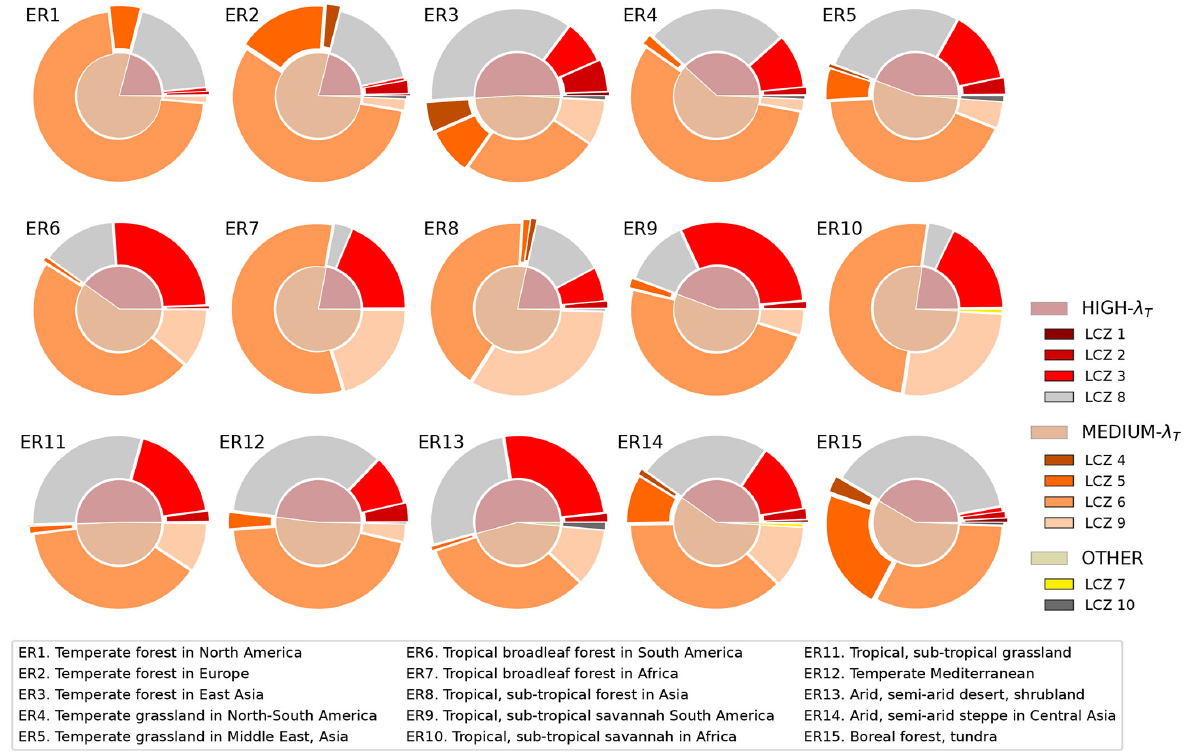
Figure 8. Distribution of the built LCZ classes for all 13135 urban centres in the Urban Centre Database, aggregated per urban ER. The inner rings indicate the HIGH (LCZs 1, 2, 3, and 8), MEDIUM (LCZs 4, 5, 6, and 9) and OTHER (LCZs 7 and 10) degree of total imperviousness ( λ T ) clusters. The outer rings depict the actual LCZ classes. The expansion of individual LCZ wedges visually reflects the differences in building height across LCZ classes (see Table 1).